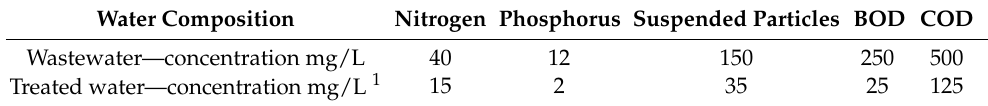
Table 10. Typical concentration values of relevant pollutants in wastewater and treated water.